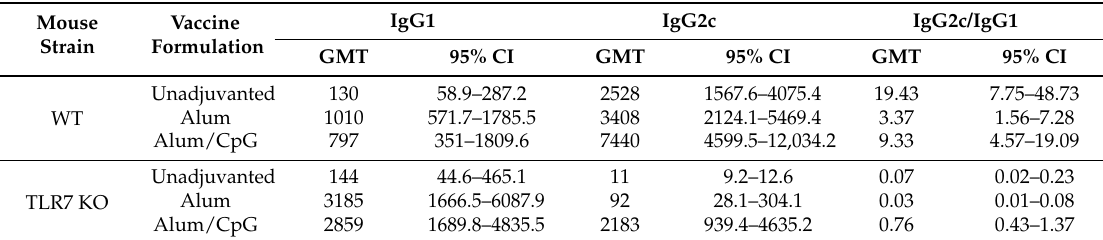
Table 1. IgG1 vs. IgG2c ratios of anti-IgE Abs in WT and TLR7 KO mice. IgG1 and IgG2c titers were determined by ELISA and correspond to the serum dilution that resulted in an absorbance value (OD 450) of 1. GMT: Geometric mean titer; CI: Confidence